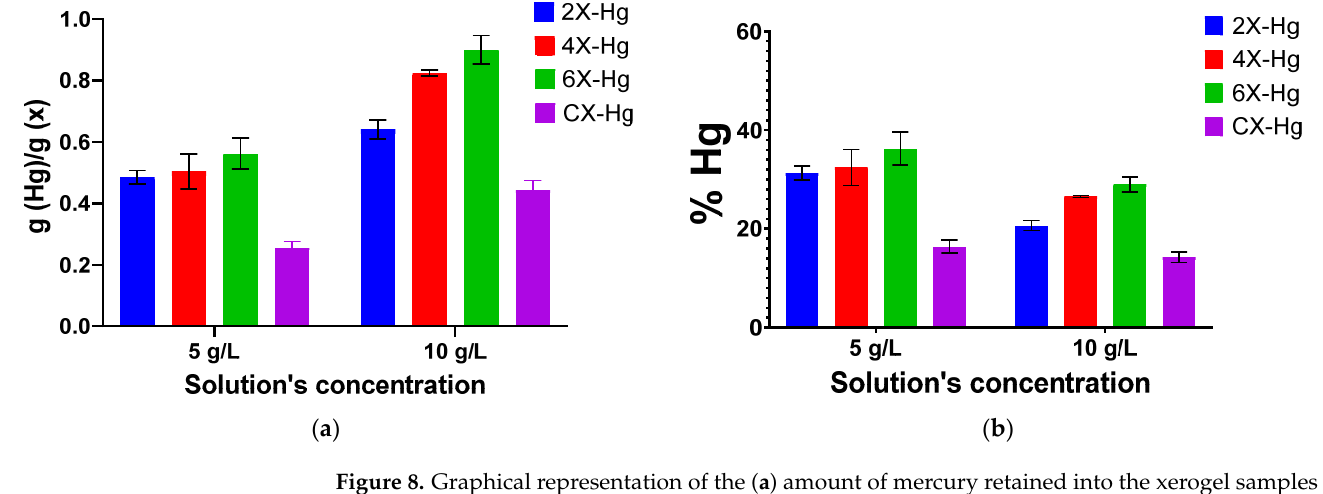
Figure 8. Graphical representation of the ( a ) amount of mercury retained into the xerogel samples and ( b ) removal percentage of mercury, as a function of the solution’s concentration and crosslinking degree. The symbol Hg in samples’ codes indicates the presence of mercury.